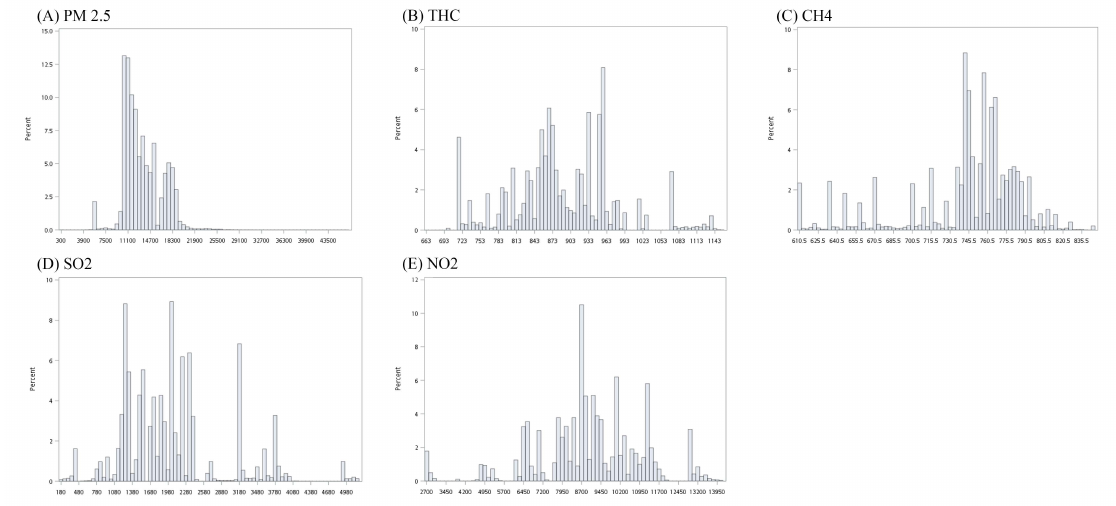
Figure 3. The distribution of annual air pollution exposures during the follow up time. ( A ) PM 2.5 ( B ) THC ( C ) CH 4 ( D ) SO 2 ( E ) NO 2